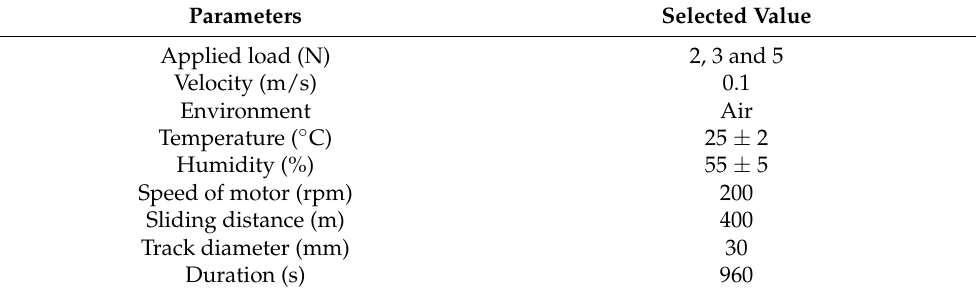
Figure 2. Schematic diagram of micro pin-on-disc tribotester.